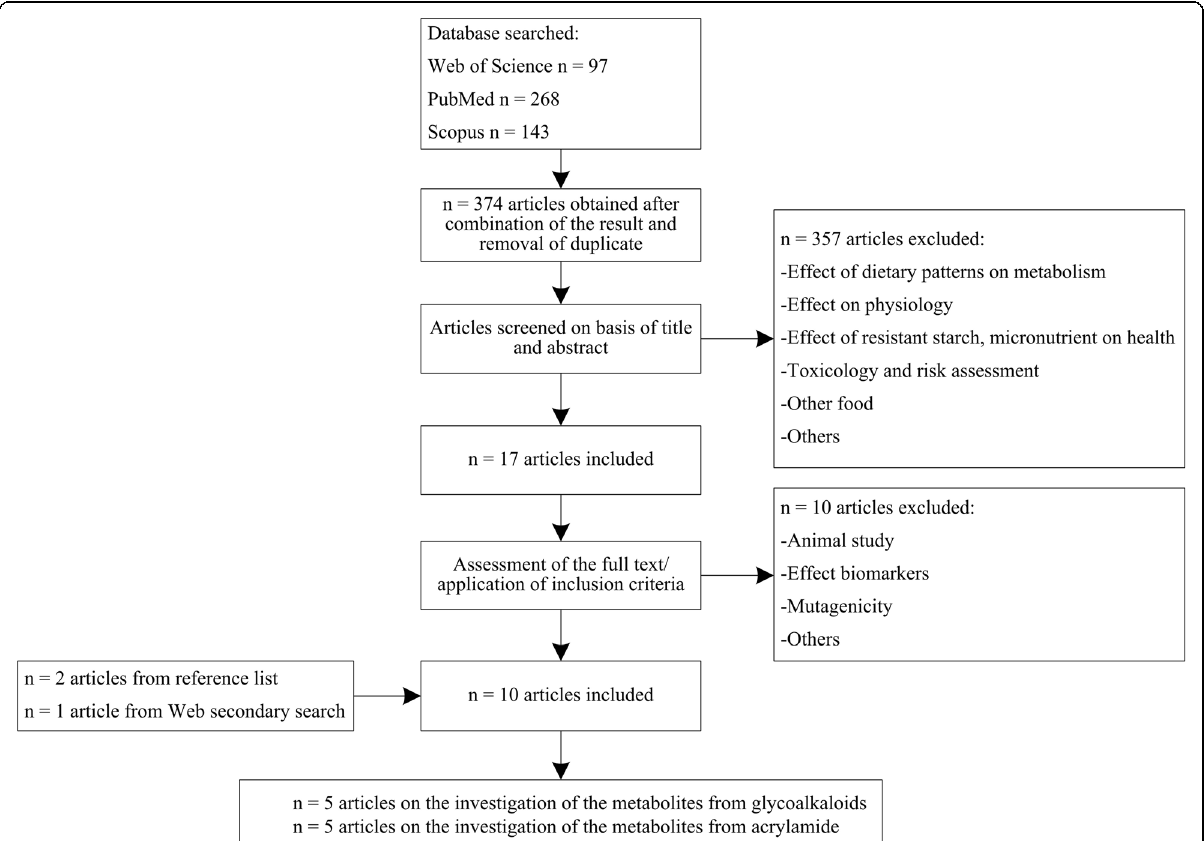
Fig. 1 Flow diagram of structured literature search for BFIs of